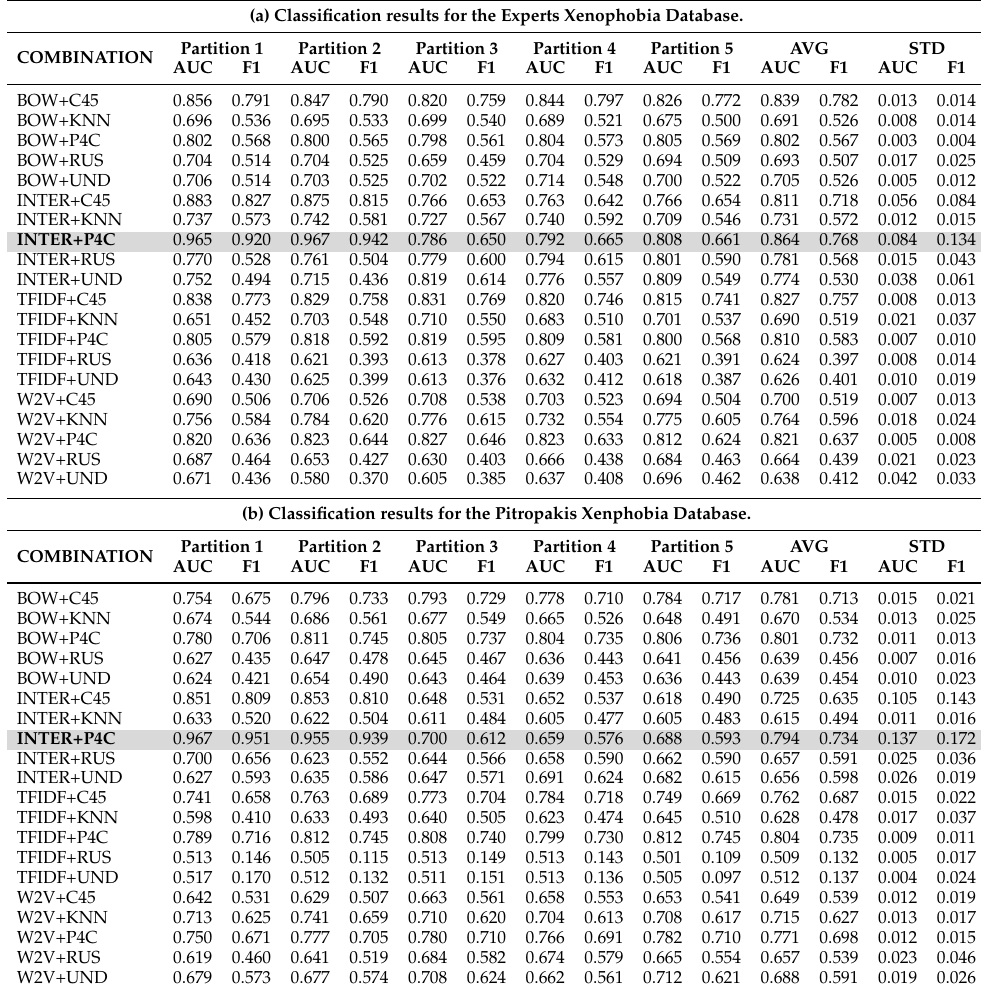
Table 9. Results of the AUC and F1 score metrics. Each row represents the combination of an embed- ding method jointly with a classifier. In AVG the best interpretable combination is INTER+P4C . (a) Classification results for the Experts Xenophobia Database.